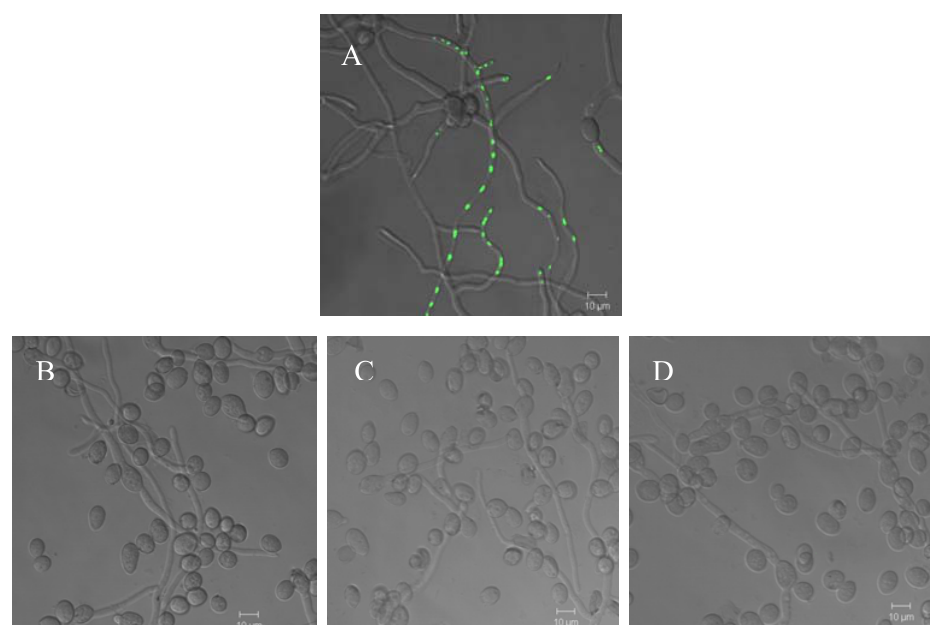
Figure 6. Effect of the diterpenoids on the B. cinerea cytoplasmatic membrane. Positive control, ethanol 70% (v/v) (A). B. cinerea in the presence of 8% (v/v) methanol (negative control) at 1 h (B), 4 h (C) and 6 h (D) of incubation; B. cinerea in the presence of 60 µg mL -1 salvic acid at 1 h (E), 4 h (F) and 6 h (G) of incubation; B. cinerea in the presence of 60 µg mL -1 acetylsalvic acid at 1 h (H), 4 h (I) and 6 h (J) of incubation. These figures are representatives of five independent